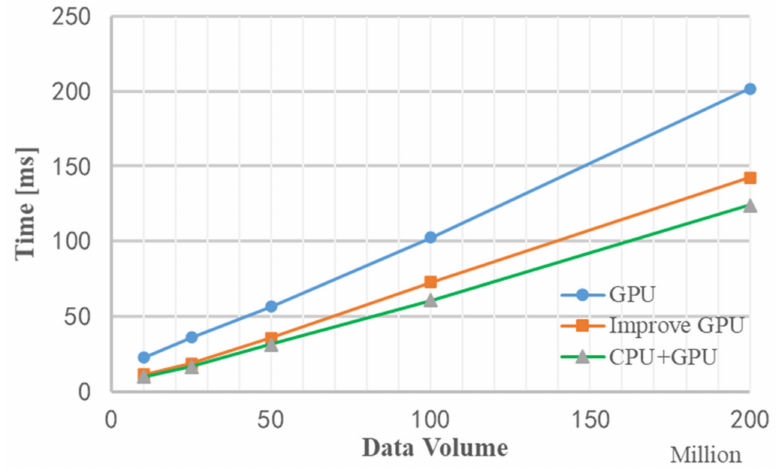
Figure 21. Comparison of the time used by the three acceleration